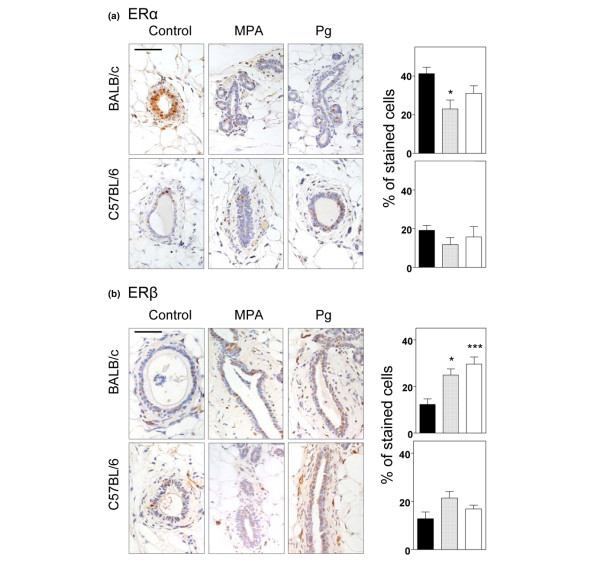
ER expression in mammary glands treated with progestins for 2 months. For both (a) ER-α and (b) ER-β, a representative image of four to 10 histological slides/group is shown. The number of stained cells was quantified and expressed as a percentage of the number of stained cells among epithelial cells in 400× fields of every slide (bar: 80 μm). A minimum of 1,500 epithelial cells/slide were counted. The right panels show the quantification in control (filled columns), MPA-treated (dotted columns), and Pg-treated (empty columns) mice (mean ± standard error). ER-α was significantly lower in C57BL/6 mice (P < 0.001), and there was a significant decrease with MPA treatment in BALB/c mice. Regarding ER-β, there was a significant increase in progestin-treated BALB/c mice. In control groups, animals were killed at diestrus; animals were treated for 2 months. *P < 0.05, ***P < 0.001 control versus treated mice. ER, estrogen receptor; MPA, medroxyprogesterone acetate; Pg, progesterone.